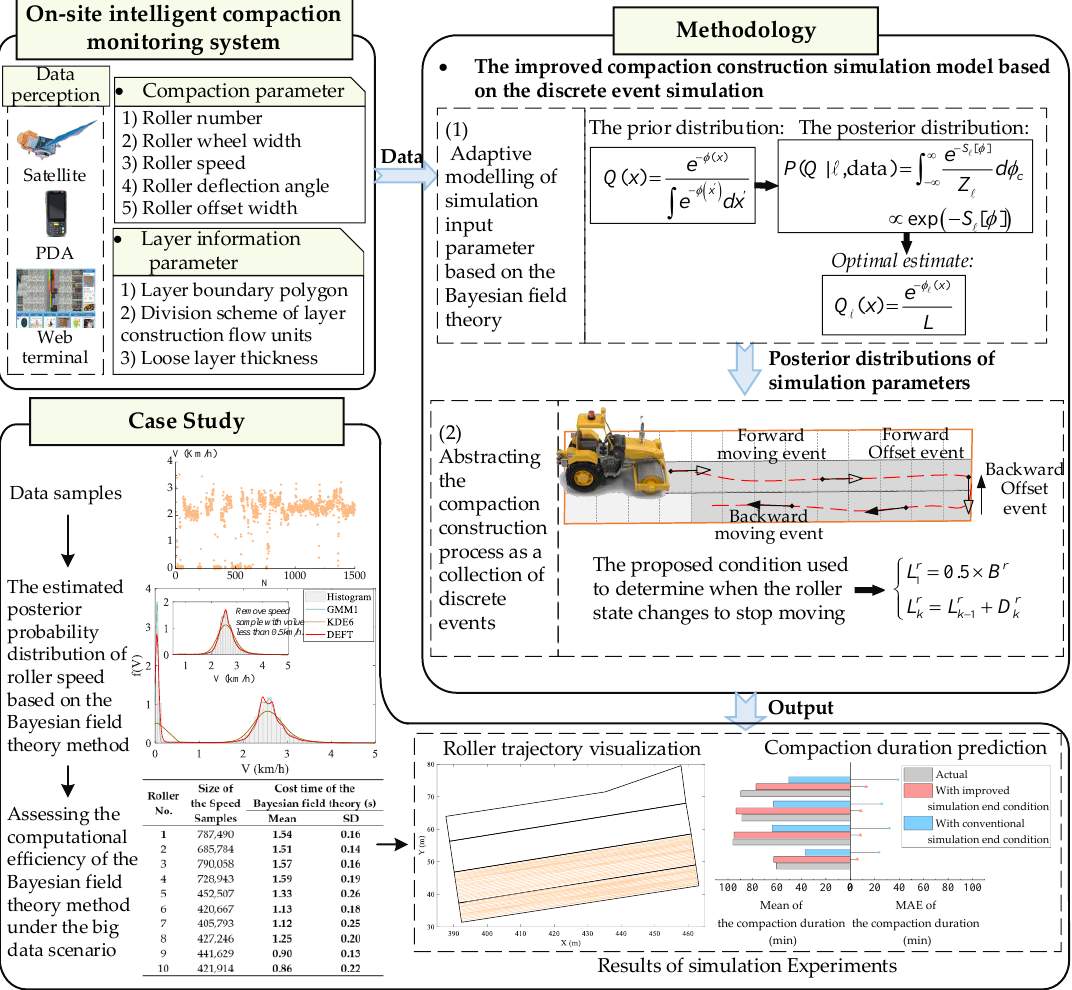
Figure 1. The overall framework of the proposed adaptive compaction construction simulation method.